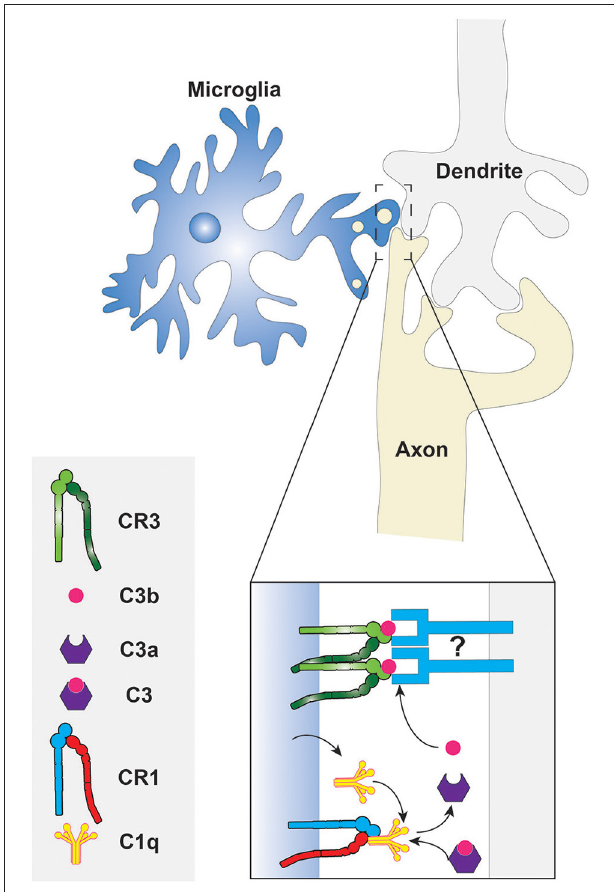
FIGURE 2 | Phagocytosis of synaptic components by microglia. The classical complement cascade is initiated by the accumulation of C1q, produced by the microglia, at degenerating synapses. The C1q molecules bind CR1 on the microglial surface to form the C1 complex resulting in the eventual cleavage of C3. The fragments of C3 then opsonize the synaptic surface for subsequent phagocytosis via CR3. What targets C3 fragments to the synaptic membrane is unknown, thus it is depicted here as an unidentified molecule that may be a protein or a phospholipid. Other components of the C1 complex and complement cascade are not shown because they have not been studied in the context of synaptic pruning.